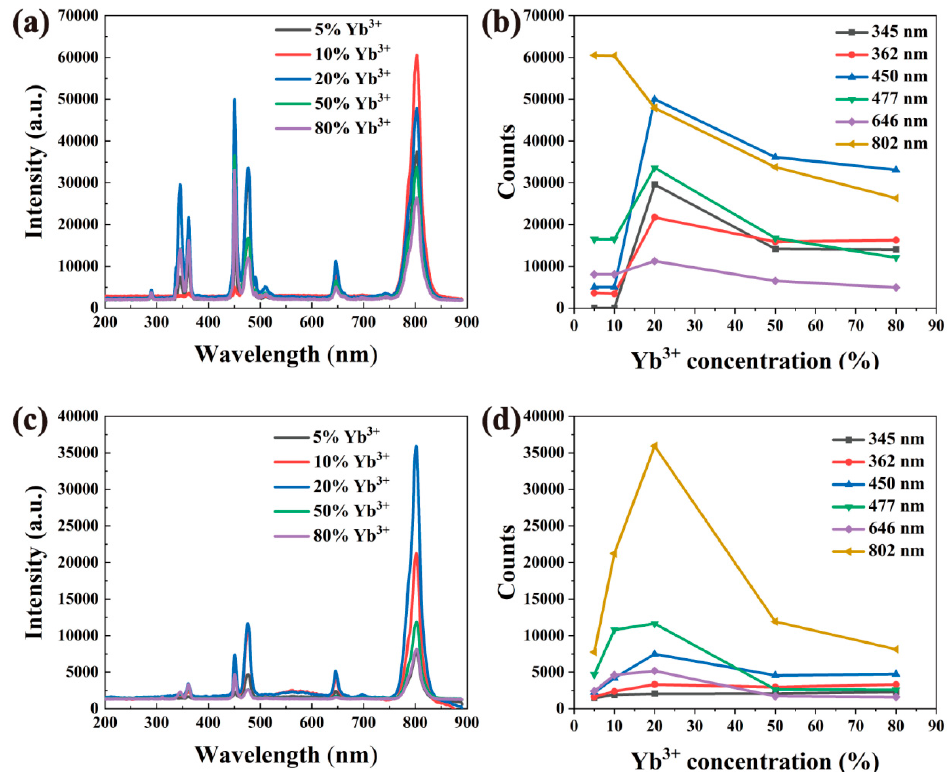
Figure 4. Fluorescence spectra of NaYF 4 : Yb 3+ , Tm 3+ and NaGdF 4 : Yb 3+ , Tm 3+ with different Yb 3+ doping ratios. ( a ) Fluorescence spectra of NaYF 4 :x%Yb 3+ ,0.5%Tm 3+ (x = 5, 10, 20, 50, 80) at 980 nm excitation. ( b ) Schematic diagram of the relationship between the maximum intensity of the luminescence peaks corresponding to NaYF 4 : Yb 3+ and Tm 3+ with different doping ratios and the concentration change. ( c ) Fluorescence spectra of NaGdF 4 :x%Yb 3+ , 0.5%Tm 3+ (x = 5, 10, 20, 50, 80) at 980 nm excitation. ( d ) Schematic diagram of the relationship between the maximum intensity of the luminescence peaks corresponding to NaGdF 4 : Yb 3+ and Tm 3+ with different doping ratios and the concentration changes.